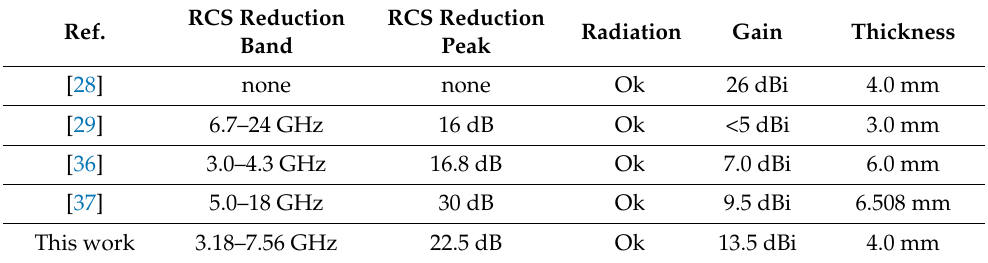
Table 1. Comparison of scattering and radiation performance for this work with other references.